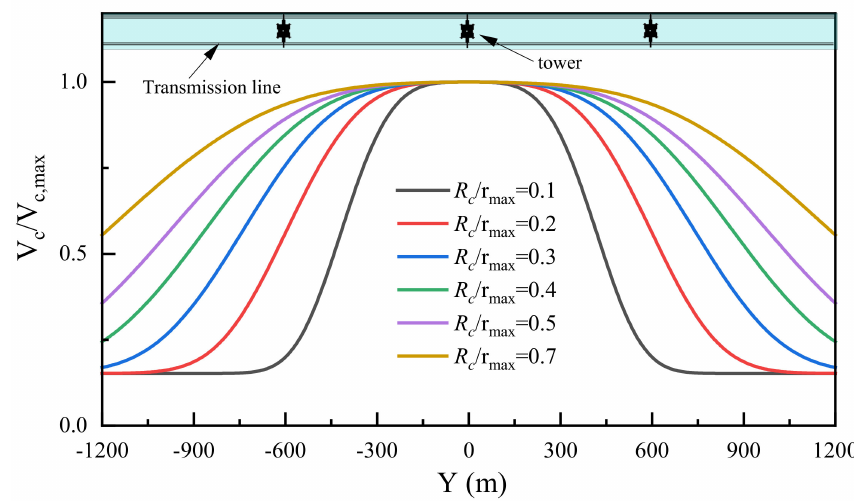
Figure 17. Variation of transverse wind profiles of downburst with R c / r max